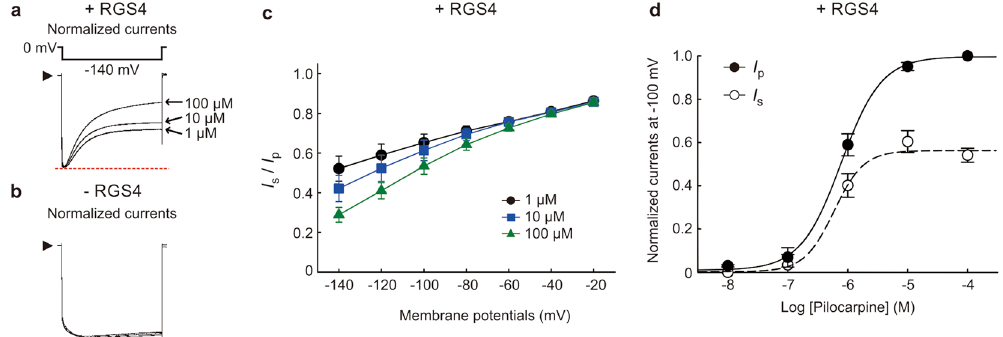
Figure 2. Effects of RGS4 on modulation of GIRK current in a pilocarpine concentration-dependent manner. ( a , b ) Pilocarpine (1, 10, 100 μ M)-induced GIRK currents in Xenopus oocytes expressing M2 muscarinic receptor, Kir3.1/Kir3.4 with ( a ) and without ( b ) RGS4 were recorded at − 140 mV with the test pulse protocol shown above. The I p evoked by different concentrations of pilocarpine (1, 10, 100 μ M) were normalized to the same level (red dashed line). Different levels of I s in the presence of different pilocarpine concentrations were observed. ( c ) The ratio of I s to I p ( I s / I p ) at hyperpolarized potentials ( − 20 mV to − 140 mV) in the applications of pilocarpine (1 µ M, black circles; 10 µ M, blue squares; 100 µ M, green triangles) in oocytes expressing RGS4. Data are means ± s.e.m., n = 6–10. ( d ) Concentration-response curves of I s (filled circles) and I p (open circles) of pilocarpine-induced GIRK current in the presence of RGS4 were fitted with the Hill equation. The maximal value of I p of pilocarpine-induced GIRK current was normalized to 1. The –logEC 50 was 6.23 ± 0.12 M for I s ; 6.11 ± 0.02 M for I p . Data are means ± s.e.m., n = 3–6.